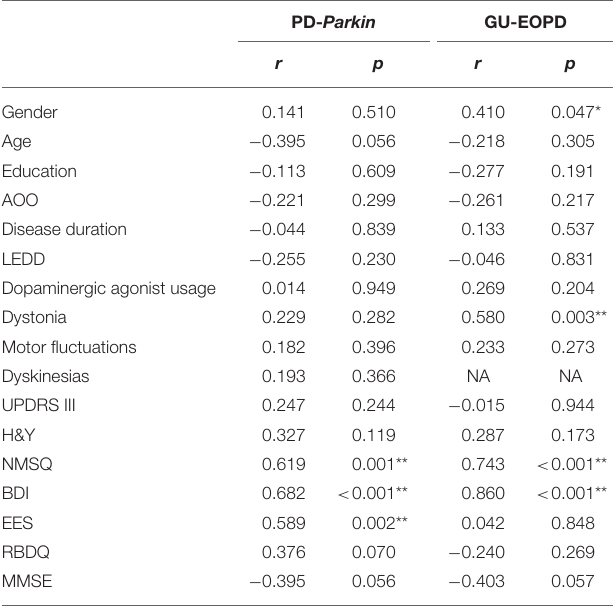
TABLE 2 | Comparison of PDQ-39 between PD- Parkin group and GU-EOPD group.